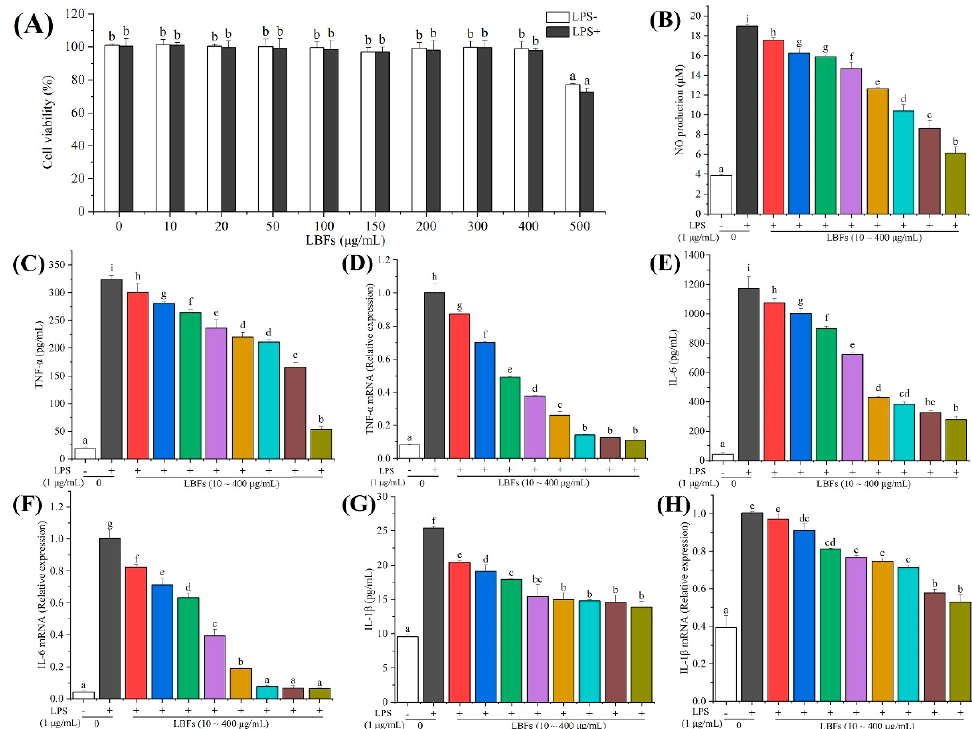
Figure 4. Cytotoxic effects on RAW264.7 cells and effects on LPS-induced pro-inflammatory cytokine production and mRNA expression of the extract of flavonoids from the fruits of Lycium barbarum . In cytotoxicity test ( A ), cells were pretreated with different concentrations (10, 20, 50, 100, 150, 200, 300, and 400 μ g/mL) of LBFs for 2 h and then treated with 1 μ g/mL of LPS for 24 h. ( B ) The NO level in the cell culture was detected by Griess assay. In the anti-inflammatory activity test, RAW264.7 cells were pretreated with different concentrations of LBFs for 2 h and then coexisted with LPS for 24 h. The culture supernatant was collected, and the levels of TNF- α ( C ), IL-6 ( E ), and IL-1 β ( G ) were detected by ELISA kits. At the same time, cellular lysate was added into the culture well to extract total mRNA, and then the mRNA expression levels of TNF- α ( D ), IL-6 ( F ), and IL-1 β ( H ) were determined by qRT-PCR. Each value is shown as means ± S.D. ( n = 3). Data with diverse letters are significantly different ( p < 0.05).